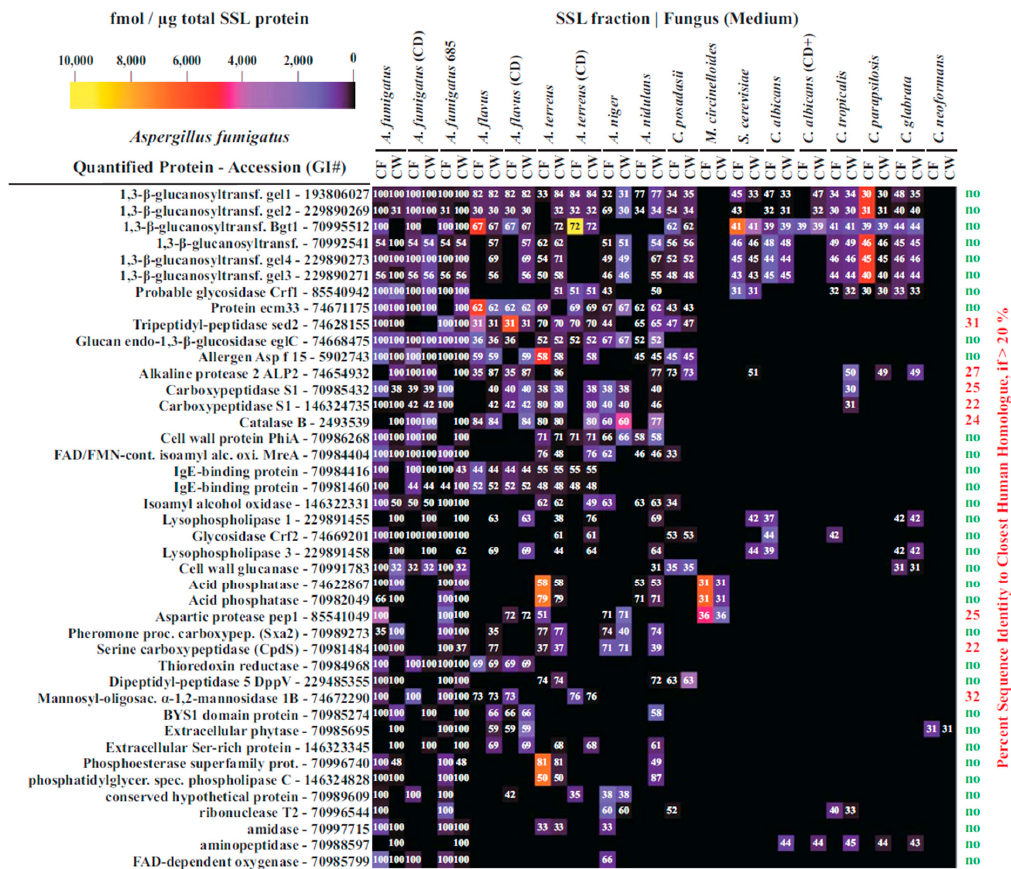
Figure 4. Quantities and homologies of fungal proteins with secreted or surface localization (SSL). The color gradients in the heat map represent quantities of the closest detected homolog in culture filtrate (CF) or cell wall (CW) extracts. The numbers in each box give the degree of homology as percent sequence identity to the corresponding protein homolog in A. fumigatus . Black boxes that contain no numbers indicate absence of a detected homolog.